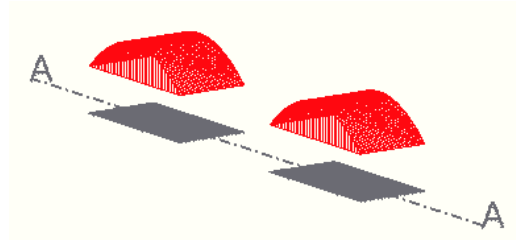
Figure 32: Parabolic load distribution along the cross-sections of a twin wheel with rectangular tire-ground contact areas (the A-A vertical section is taken along the cross-section of the twin wheel).